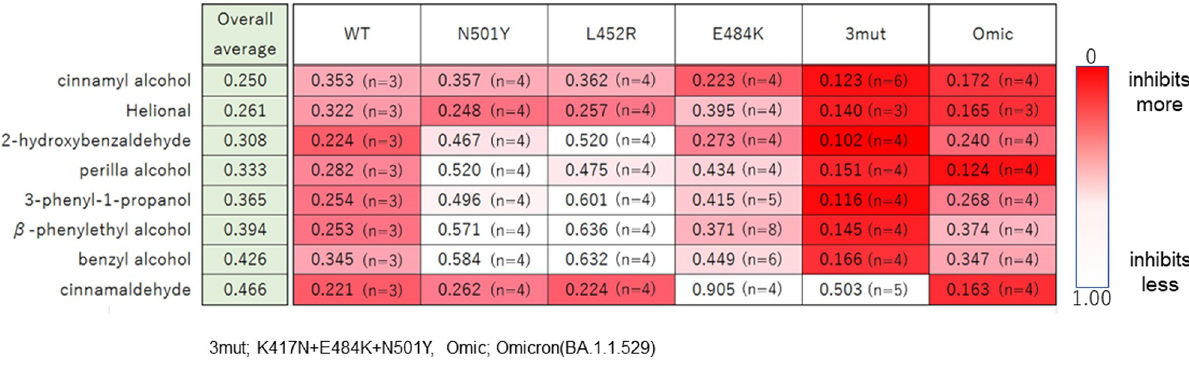
Fig 4. Ranking and heatmap of the top eight flavor/fragrance compositions inhibiting the binding between hACE2 and vRBDs. The averages were calculated from each value corresponding to vRBD-hACE2 binding measured using vRBDs. Overall average column shows values of all data using WT and variants. Values in the heatmap are the vRBD-hACE2 binding activities measured using 0.5% (v/v) flavor/fragrance compositions. Samples with vigorous inhibition are in